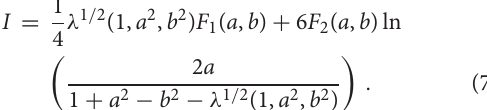
FIGURE 28 | Relic density (left panel) and both relic density and direct search (XENON 1T 2018) (right panel) allowed parameter space plotted in m N with different range of sin θ : 0.01